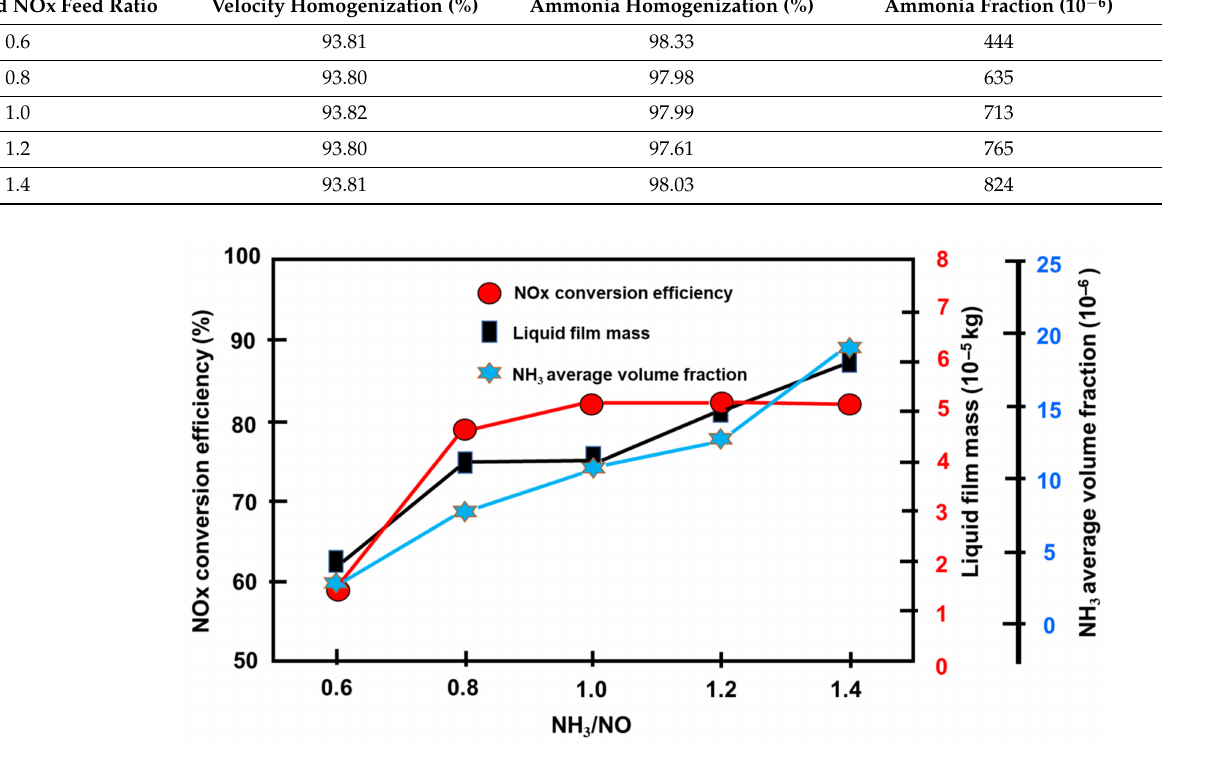
Figure 14. Performance at various NH 3 /NOx feed ratios